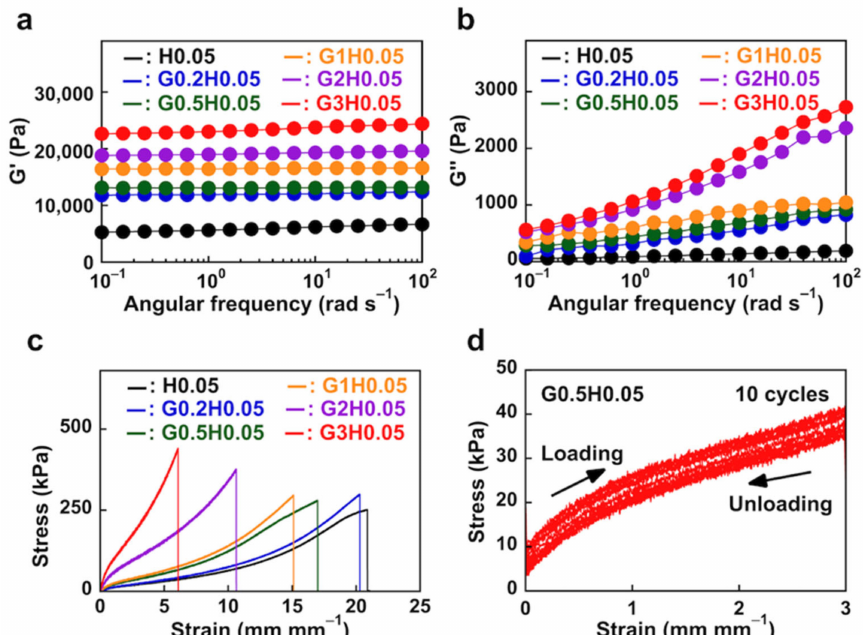
Figure 7. ( a ) Storage moduli (G (cid:48) ) and ( b ) loss moduli (G”) of NC hydrogels at 25 ◦ C. ( c ) Stress– strain curves for NC hydrogels with a strain rate of 100 mm min − 1 at 25 ◦ C. ( d ) Cyclic tensile loading − unloading curves for G0.5H0.05 at 300% tensile